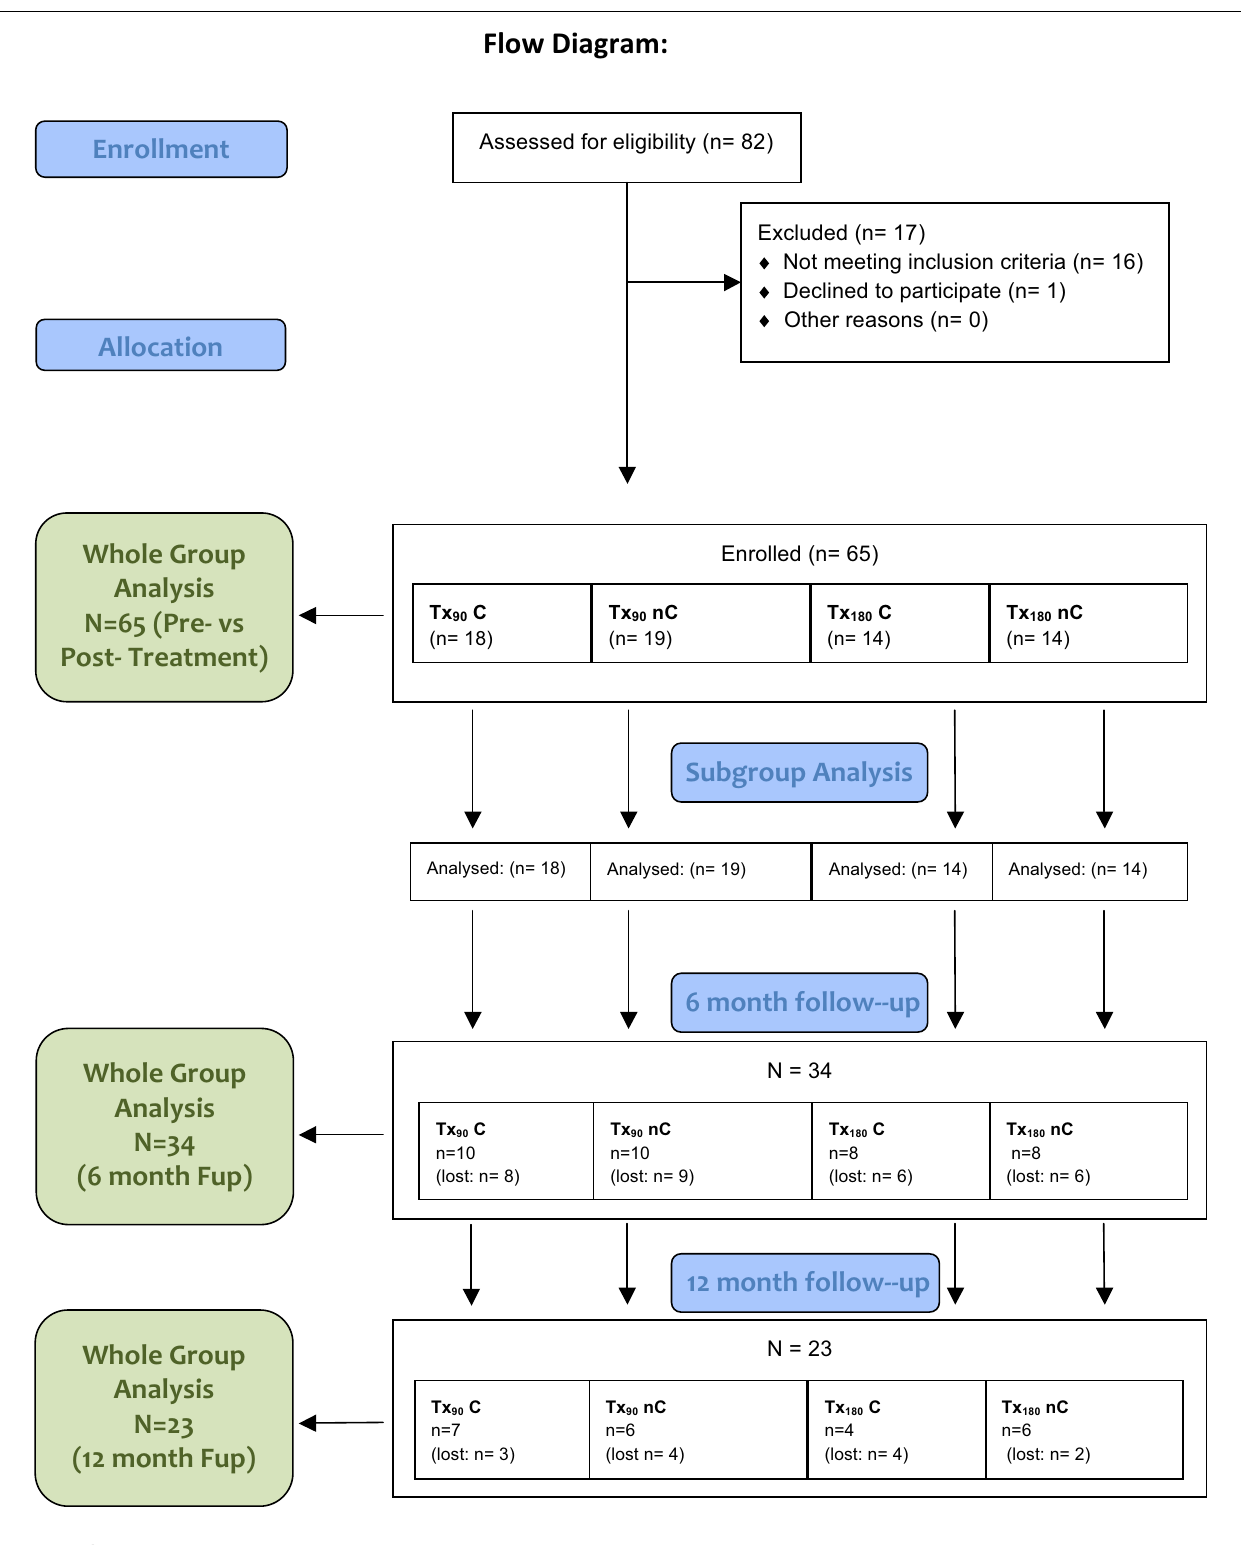
FIGURE 1 | Summary of the trial and group allocation . Note that (1) all patients received the allocated treatment, (2) the n for “patients lost” refers to the number of participants having completed the MAL, (3) for attending the follow-up did not necessarily completed all tests;